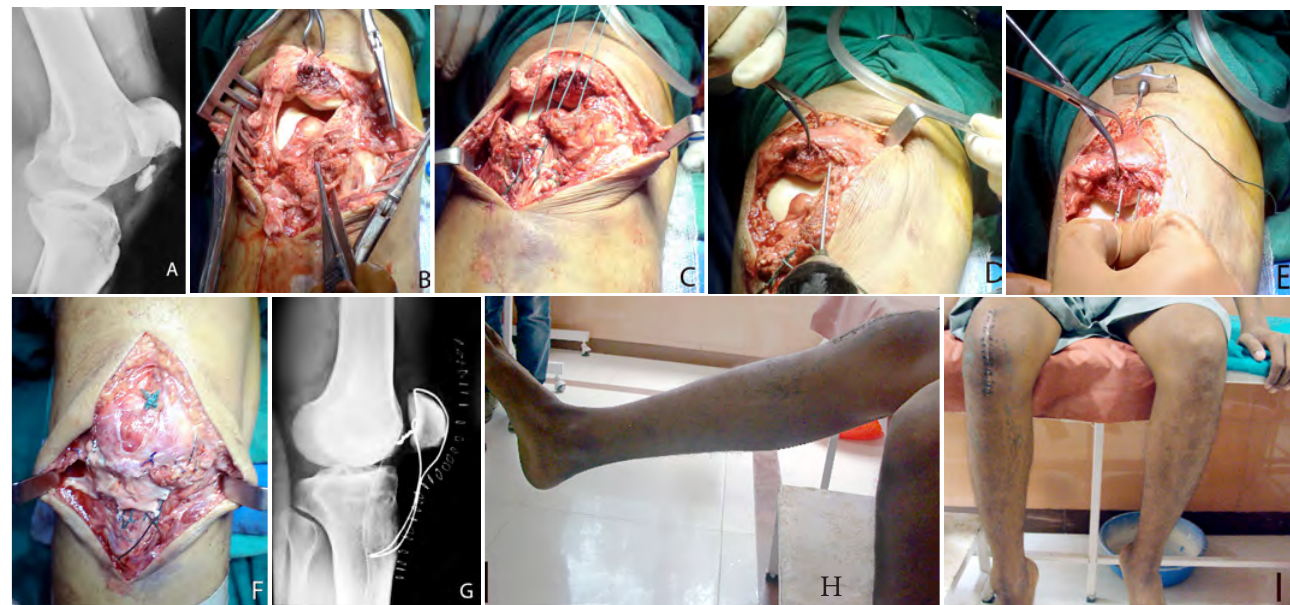
Fig 1 : ( A ) Lateral radiograph of comminuted displaced lower pole fracture; ( B ) shows extra-articular location of the fracture ; ( C ) Drill holes were made using a 2 mm drill bit directed through the posterior margin of fractured surface of proximal fragment and directed to the antero-superior border of patella; ( D ) Interlocking running Krackow suture using #5 Ethibond1 each border of patellar tendon; ( E ) Free ends of suture passing through a bone marrow aspiration cannula; ( F ) Intraoperative photograph after the repair of retinucula. Fixation is augmented with patellotibial stainless steel wire cerclage.; ( G ) Postoperative lateral radiograph; ( H,I ) Function at 4 months follow-up.